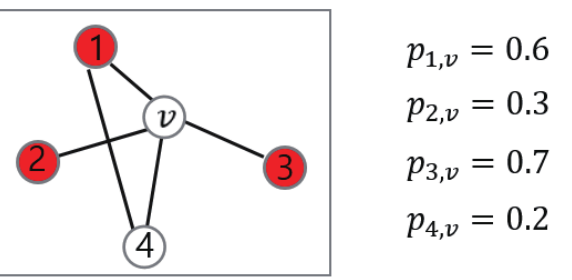
Figure 2. A simple observed graph G obs with infection probabilities p i , v , ( i = 1,2,3,4 ) used in Example